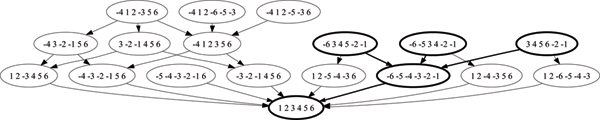
The signature graph for πA = -4, 1, -5,2, -6, 3, πB = -4, 1, 6, 2, -5, 3, and πL = 1, 2, 3, 4, 5, 6.